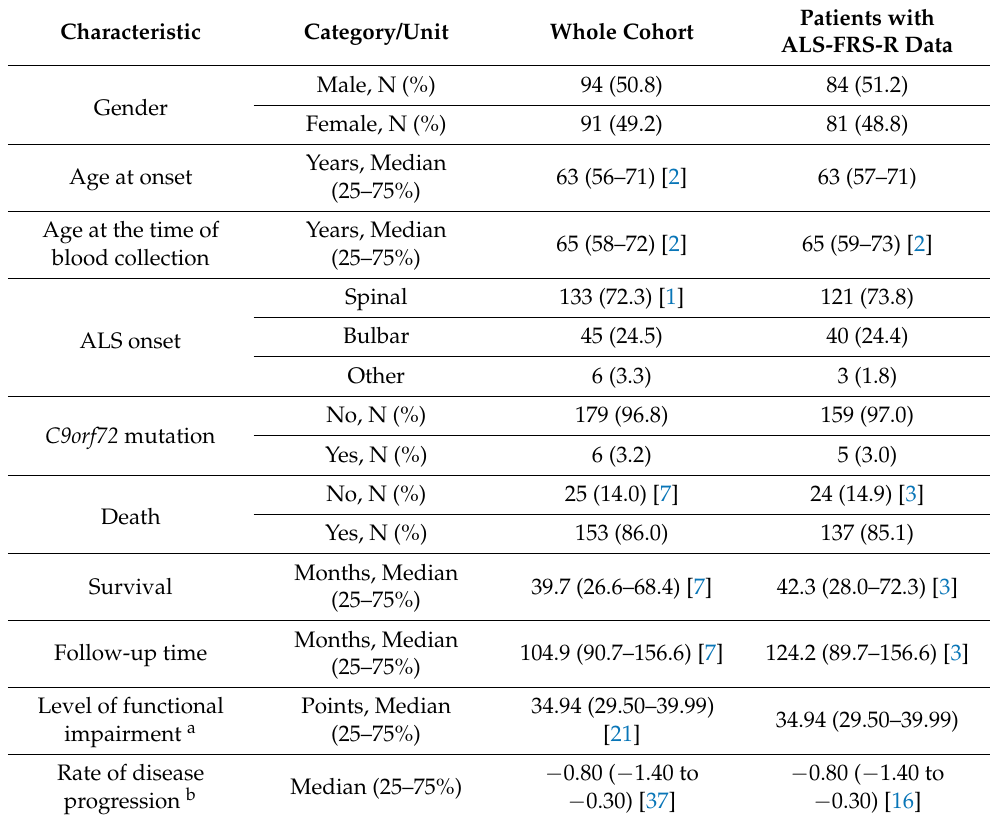
Table 1. Clinical characteristics of ALS patients for the whole cohort (N = 185) and for patients with available ALS-FRS-R data (N =